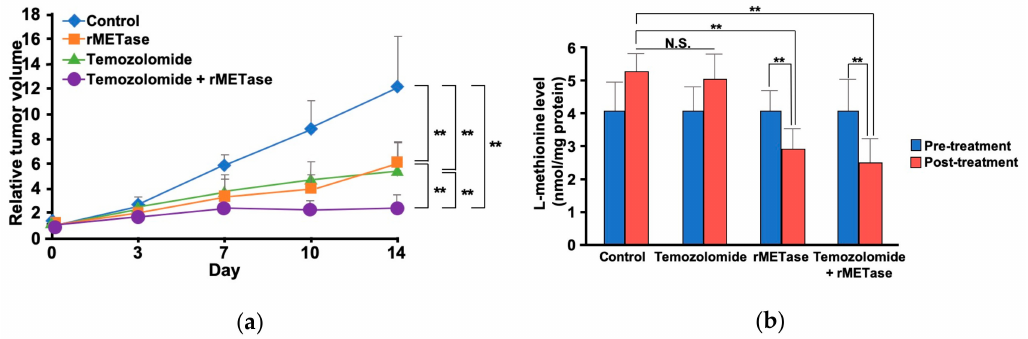
Figure 5. The first report of recombinant methioninase (rMETase) combined with chemotherapy on an orthotopic xenograft (PDOX) model. ( a ) Comparison of treatment. ( b ) Intra-tumoral methionine level after recombinant methioninase (rMETase). ** p < 0.01, error bars show the SD